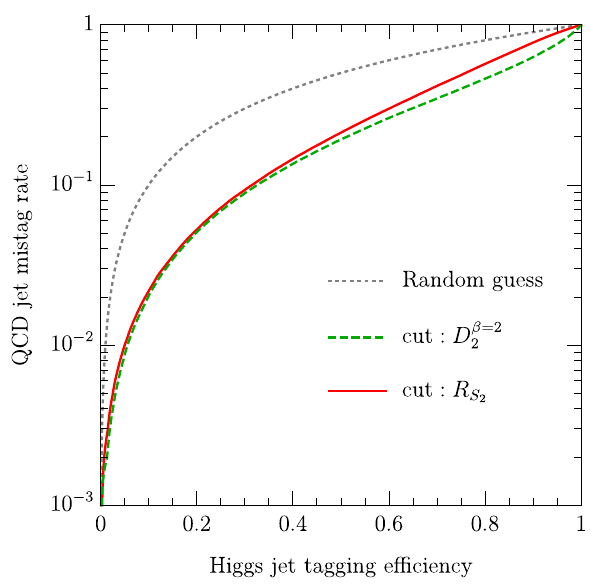
Figure 5 . ROC curves of D 2 and R S